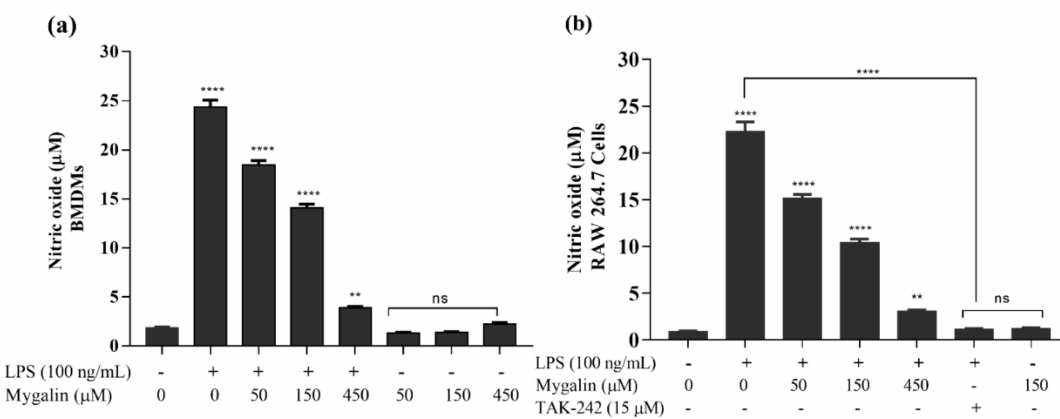
Figure 7. E ff ects of mygalin on the production of nitric oxide (NO) induced by LPS in macrophages. The cells were pretreated for 1 h with mygalin (50,150 or 450 µ M), and then LPS was added. The culture supernatant was obtained after 24 h to quantify the NO level. ( a ) Bone marrow-derived macrophages (BMDMs) and ( b ) RAW 264.7 cells. The data represent the mean ± SEM of three independent experiments performed in triplicate (** p < 0.01, **** p < 0.0001 compared to LPS) and ns (not significant) compared to the untreated